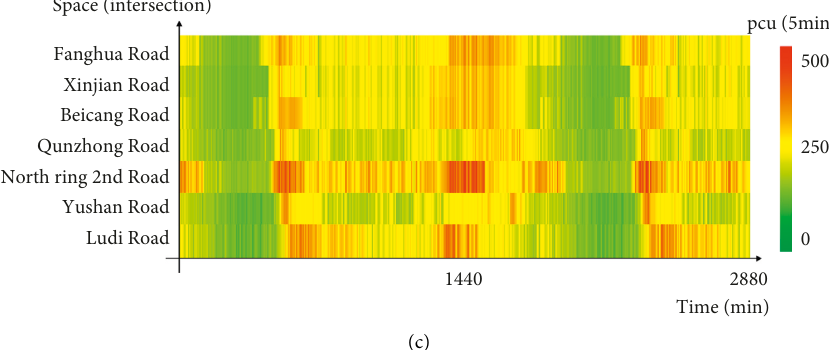
Figure 6: The 48-hour traffic volume and heat map of each intersection. (a) Traffic volume trend on October 19. (b) Traffic volume trend on October 20. (c) Heat map of each